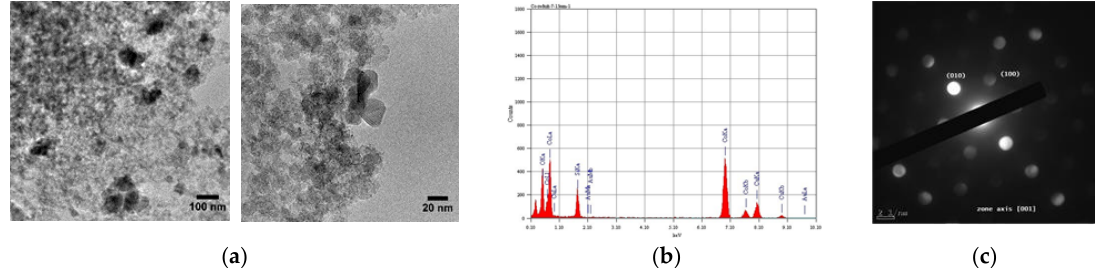
Figure 2. Transmission electronic microscopy (TEM) images recorded for reduced Co/SiO 2 catalyst ( a ), energy dispersive x-ray spectroscopy (EDS) ( b ) and electron diffraction analysis ( c ). 2.2. Hydrogenation of Furfural in Batch Reactor.